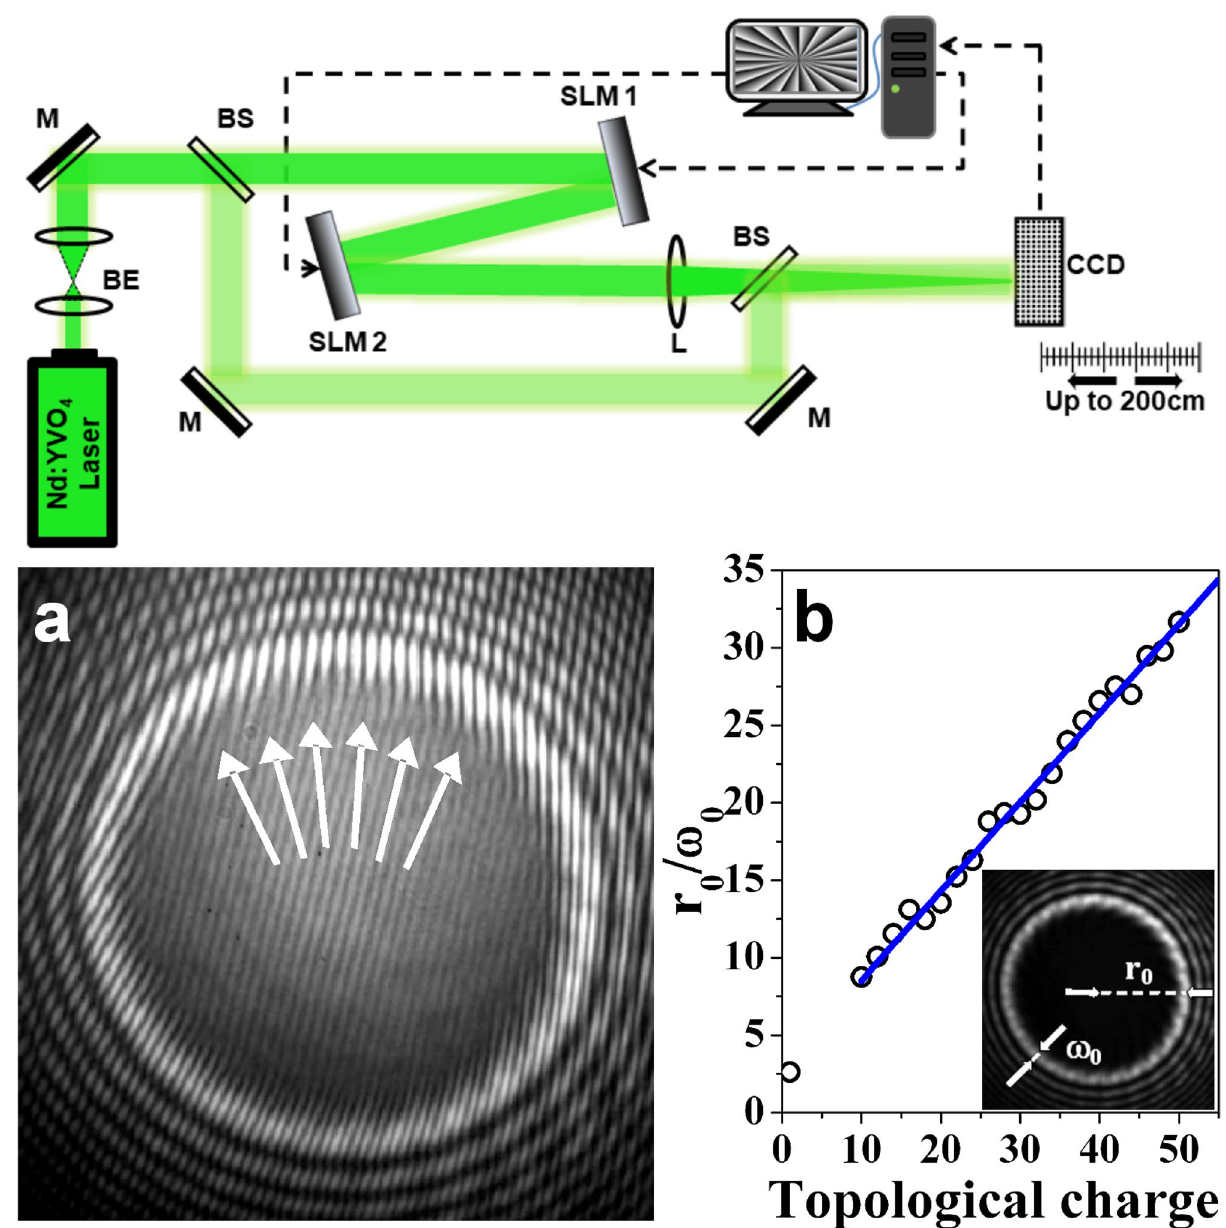
Figure 2. Top—experimental setup. Nd:YVO 4 , continuous-wave frequency-doubled solid-state laser emitting at a wavelength (cid:31) =532 nm; BS, beam splitters; M, flat silver mirrors; SLM, reflective spatial light modulators (model Pluto, Holoeye Photonics); L, focusing lens (diameter 2.5 cm, f =100 cm); CCD, charge-coupled device camera. Bottom: (a) Magnified interference pattern recorded in front of the lens when SLM1 is programmed to imprint on the flat phase front of the incoming Gaussian beam the helical phase of an optical vortex with a topological charge 25. SLM2 is switched off. Arrows point to the positions of 6 from the 25 decayed OVs. (b) Dependence of the ring radius-to-width ratio r 0 /ω 0 on the topological charge encoded by one of the SLMs at a fixed distance of 50 cm behind it. Inset (shrunken): Intensity distribution of the bright vortex ring shown in panel (a) when the reference arm of the interferometer is blocked, with designation of r 0 and ω 0